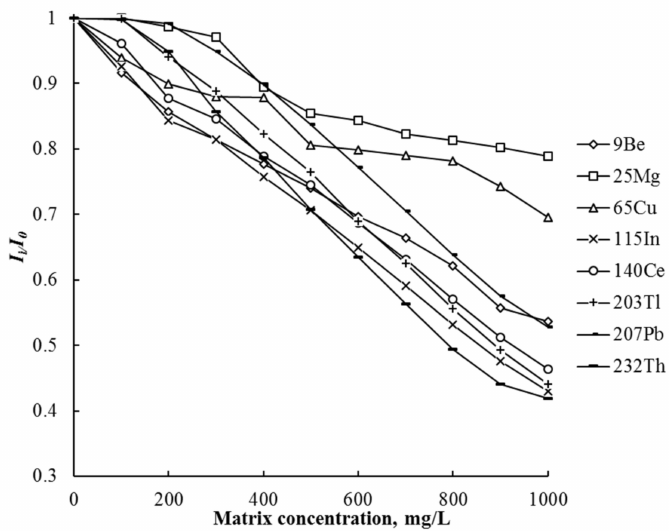
Figure 2. Dependence of the analytical signal ratios ( I i / I 0 ) on the Sm-Co concentration in solution: I 0 —10 µ g/L standard solution; I i —10 µ g/L standard solution with matrix (Sm-Co 500 mg/L: Sm 200 mg/L, Co 300